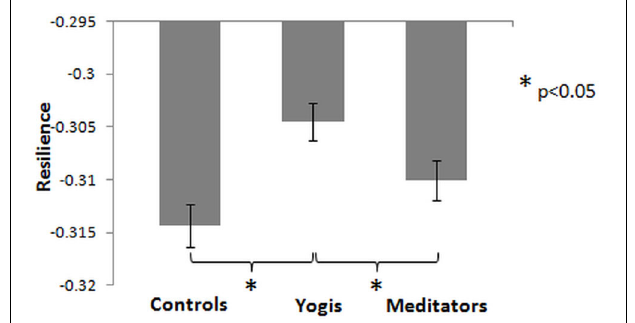
FIGURE 4 | Mean of functional network resilience, measured as the change in global efficiency after removal of the 15 nodes with the highest degree centrality. Less decrease means higher resilience. Error bars represent the standard error of the mean. P -values are based on two-tailed independent samples t